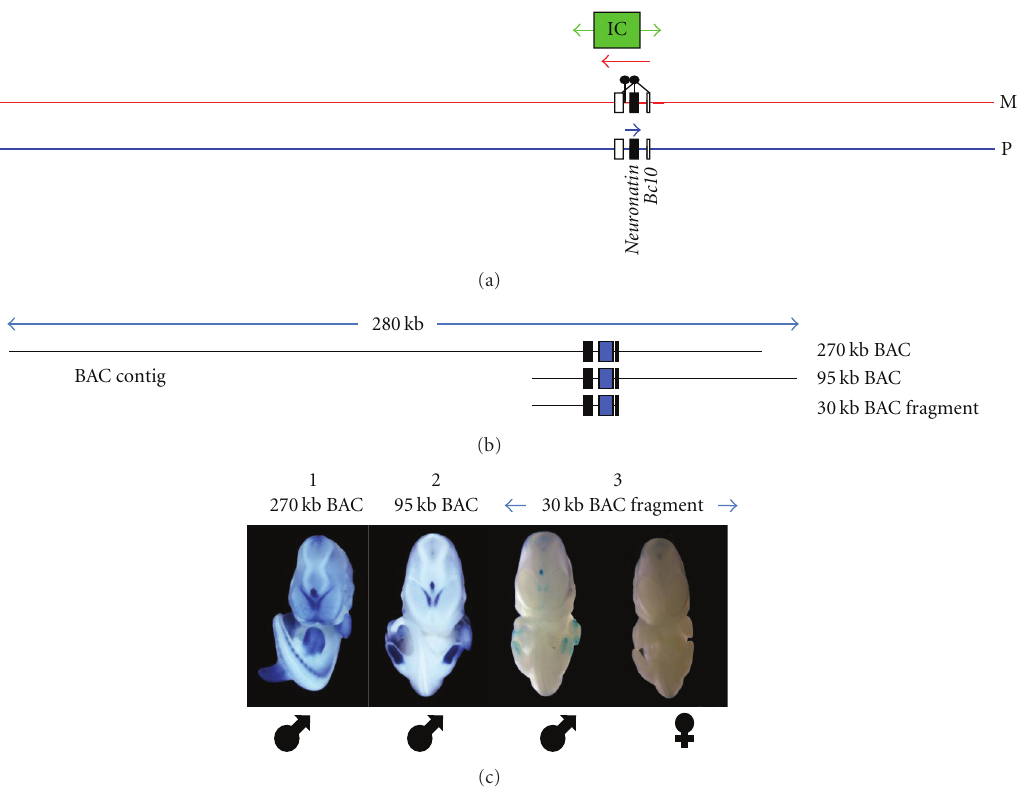
Figure 3: Mouse distal chromosome 2 contains a minimalistic imprinted locus. (a) A diagrammatic representation of mouse distal chromosome 2 imprinted region with maternal inheritance indicated in red and paternal inheritance indicated in blue. Genes are represented by the boxes with the parent-of-origin expression indicated by either a red (maternal) or blue (paternal) arrow. DNA methylation is represented by the black lollypops. Green box indicates position of proposed IC whilst green doubleheaded arrow indicates the known region influenced by this IC. (b) BAC clones and subclone used to examine expression, imprinting, and function. Blue boxes indicate the position of lacZ reporter. (c) Images of transgenic embryos inheriting the modified BACs through either the maternal or paternal germline as indicated by gender symbols below image. Expression of Neuronatin from the transgenic insertion is revealed by lacZ reporter